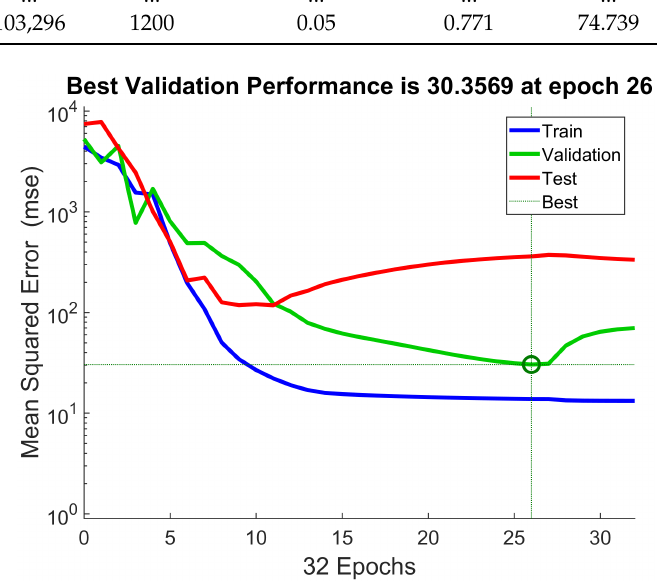
Figure 7. Example accuracy evolution of the training, validation and test